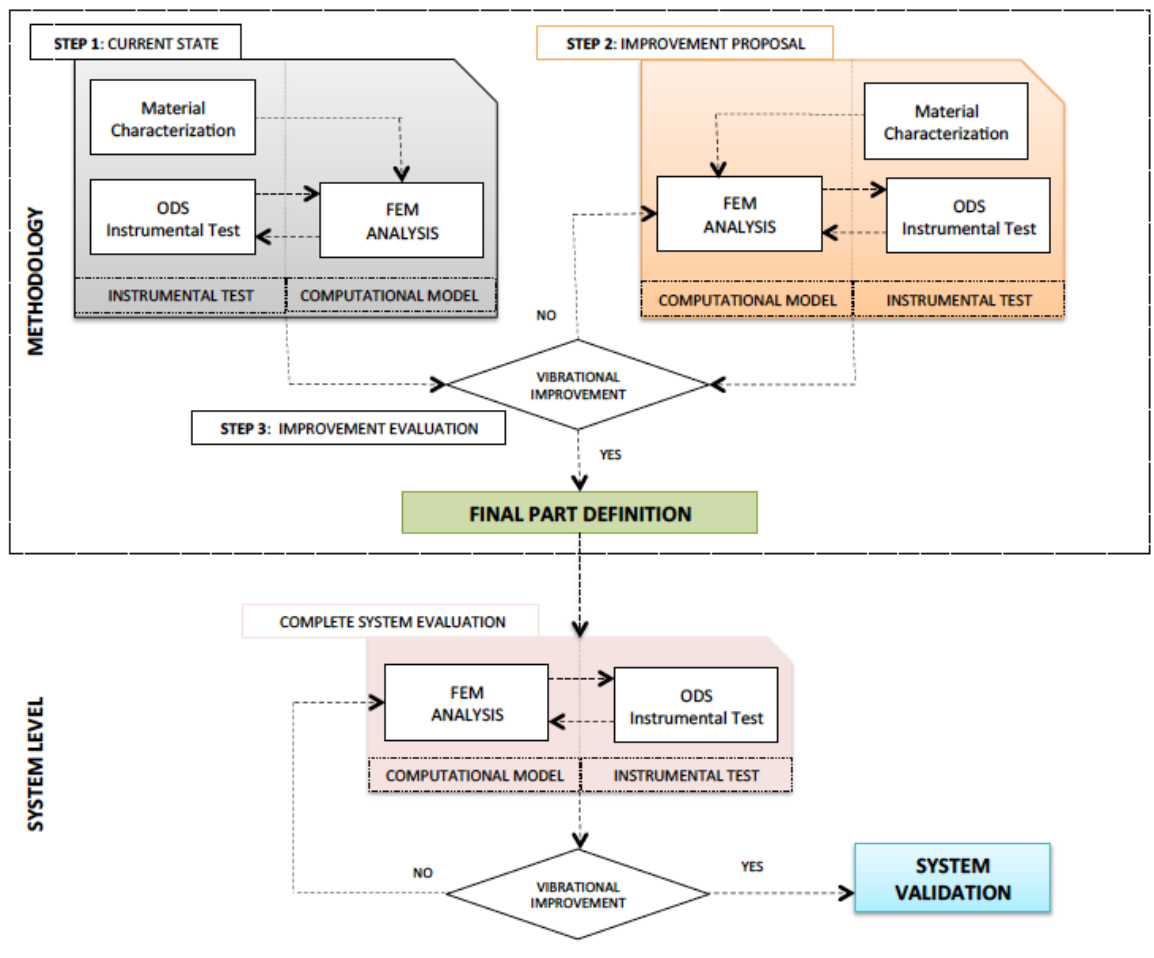
Figure 1. Hybrid approach to improve vibrational behavior of structural